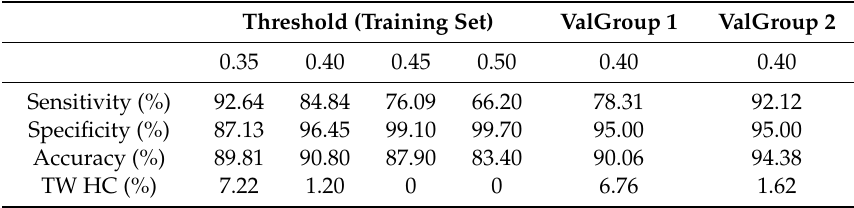
Table 2. Tremor classification method—training and